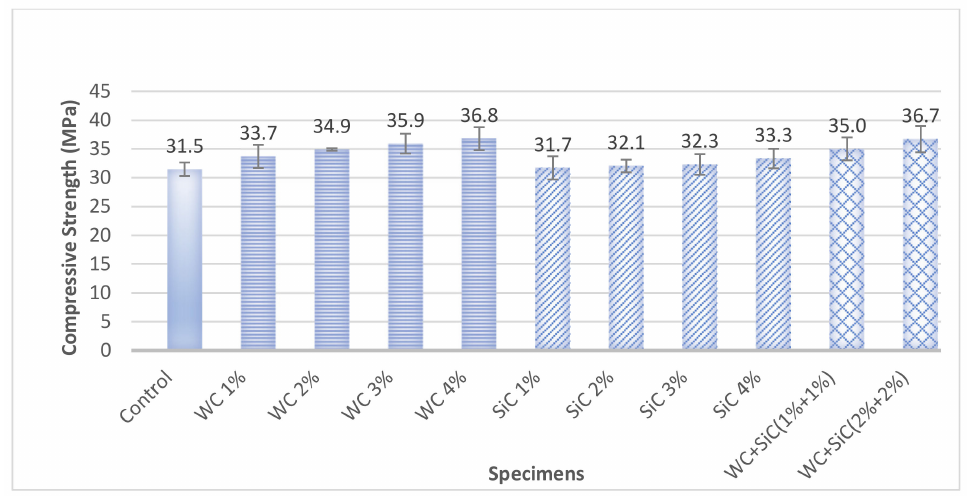
Figure 5. Compressive Strength of Specimens at 28 days.